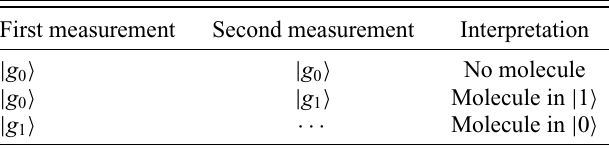
TABLE III. Interpretation of measurement results of the atom in the blockade detection scheme. For an initial measurement result of | g 1 (cid:2) , no further information can be gained from a second measurement of the same atom-molecule system. First measurement Second measurement